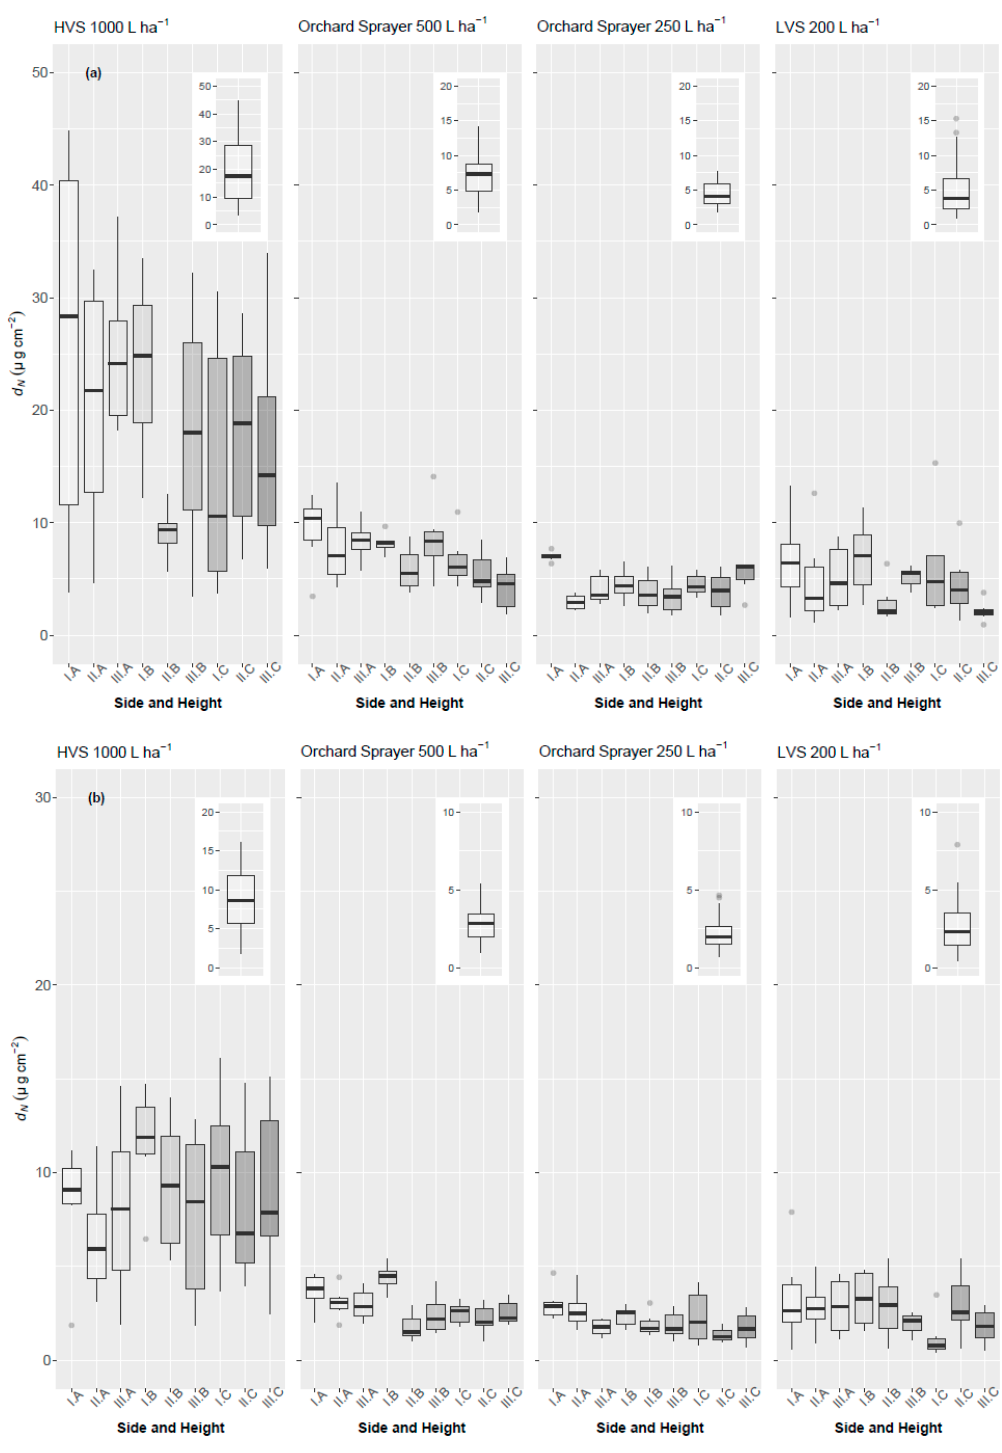
Figure 5. Normalized deposition ( d N ) for different sides (II—interior part of the vine) and heights (A-lower—see Figure 3 for details) of vines for ( a ) the trellis and ( b ) the goblet training system. The insets show d N values for all leaves in each sprayer treatment (note the different scale for the HVS inset). Boxplots show the median for each treatment, box boundaries show the 25th and 50th percentile, while whiskers extend to 1.5 times the interquartile range (IQR). Points beyond 1.5 times the IQR are plotted individually. See text for results of statistical